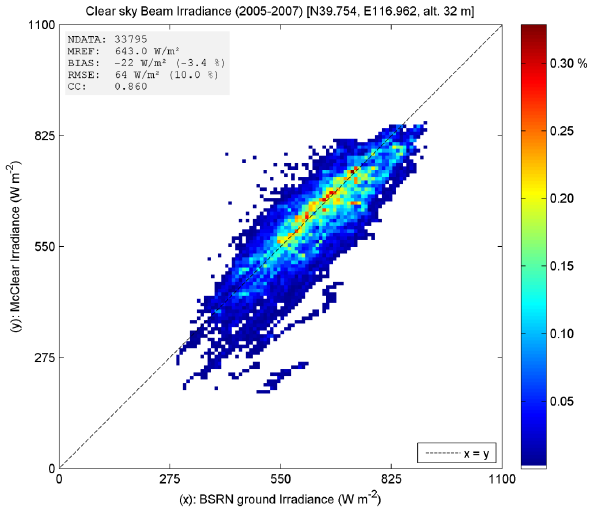
Fig. 11. Scatter density plot between BSRN 1min clear-sky data and McClear. Xianghe. Beam clearness index